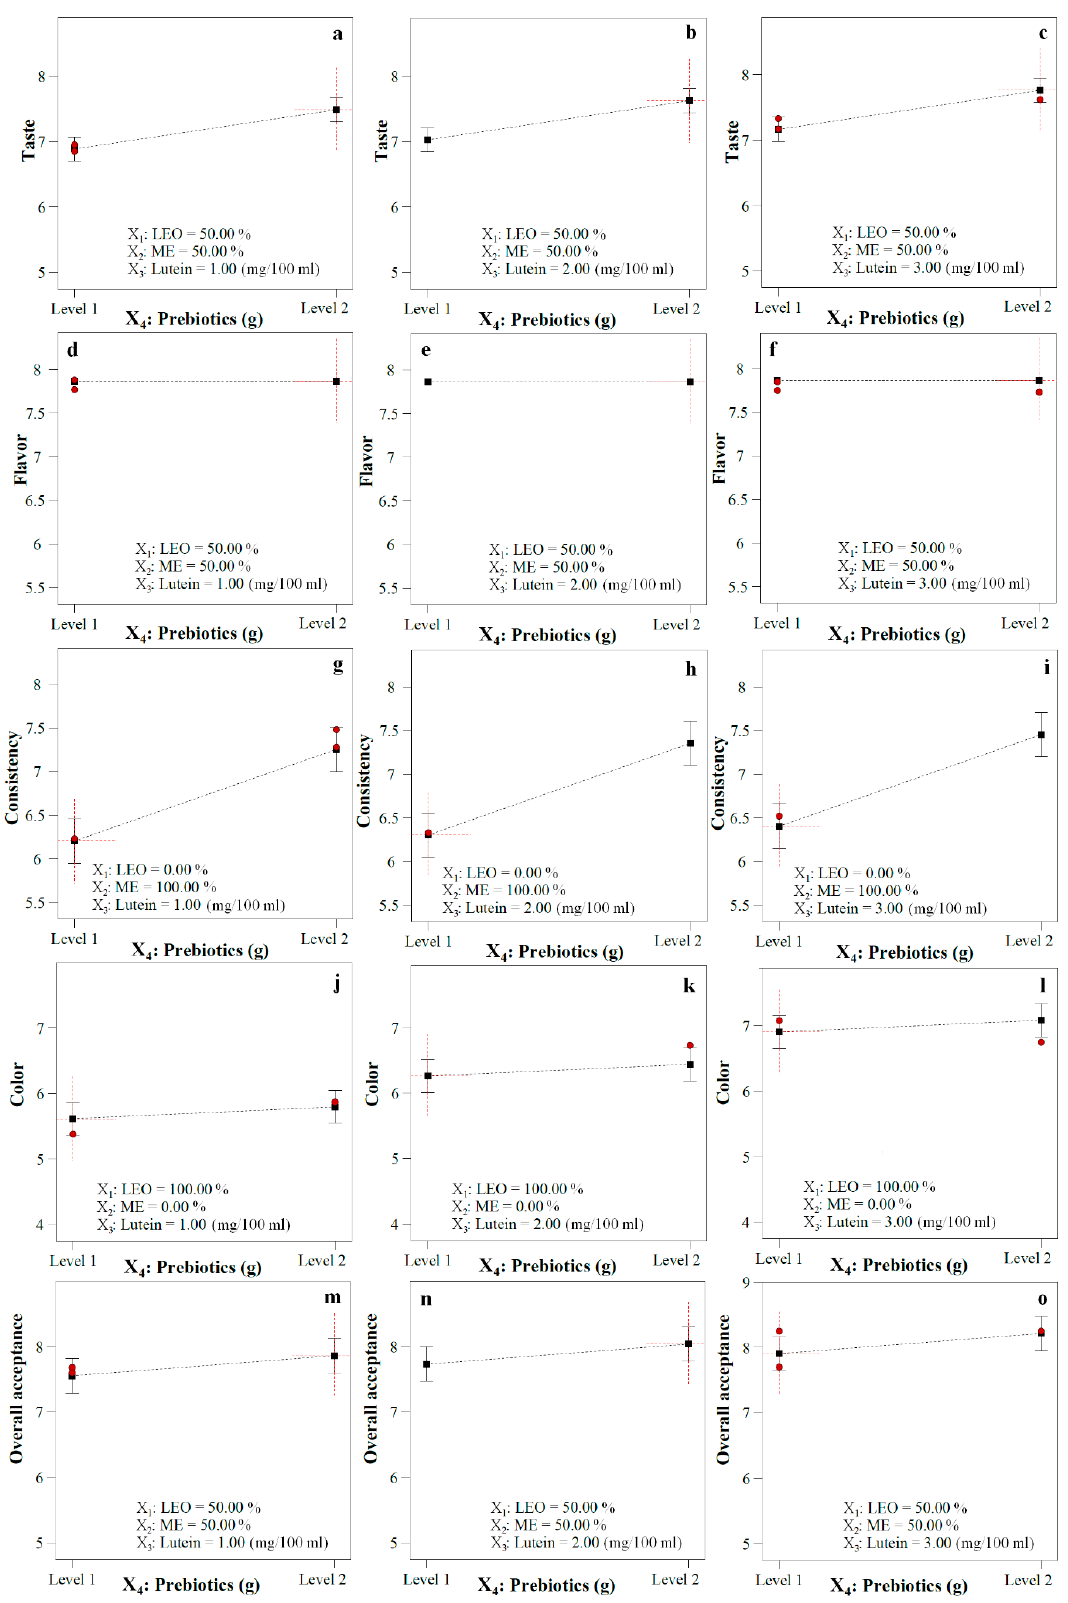
Figure 3. The effect of the presence and absence of prebiotics on the ( a – c ) taste, ( d – f ) flavor, ( g – i ) texture, ( j – l ) color, and ( m – o ) overall acceptance of beverages at specified lutein content acquired using a constant LEO/ME combination which is mentioned in the figures (in color) .